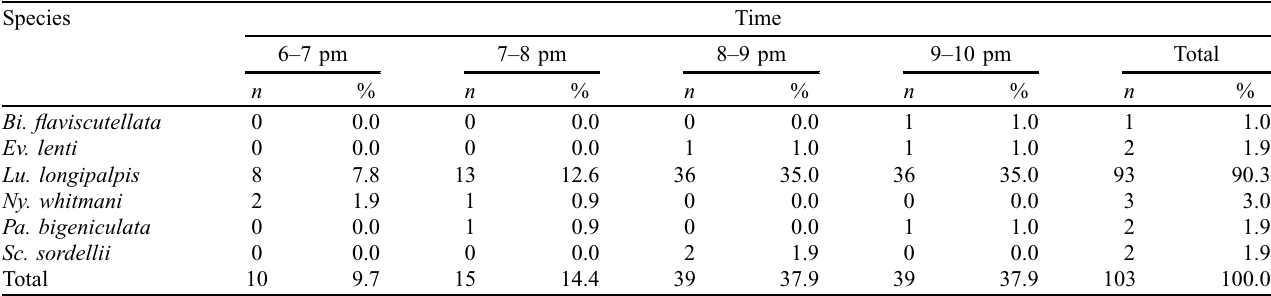
Table 3. Distribution of phlebotomines collected in a Shannon trap by hour in peridomiciles and forest fragment, Campo Grande, Mato Grosso do Sul, Midwest Brazil,